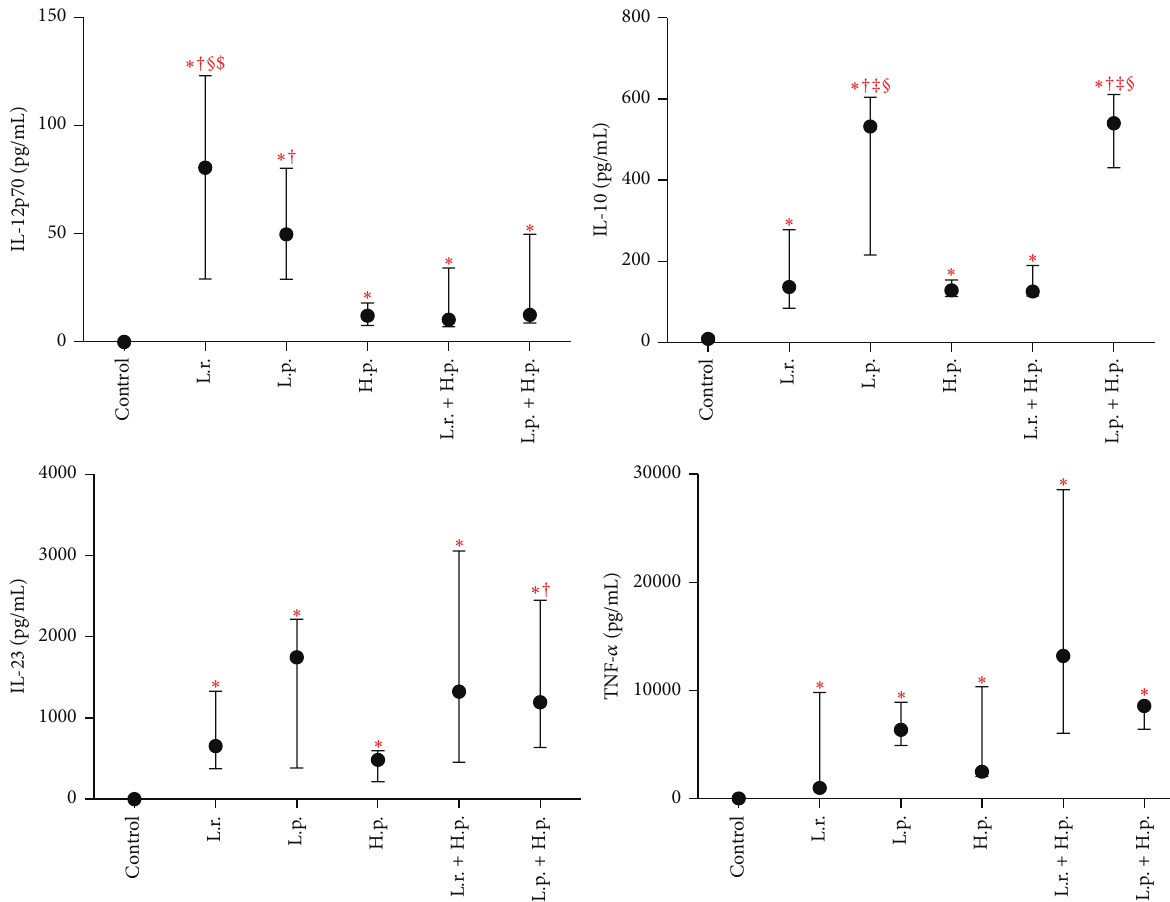
Figure 2: Effect of the examined bacteria and their mixtures on the production of cytokines by DCs population. Values expressed as medians from six independent experiments and interquartile ranges [Q1–Q3]; control: unstipulated DCs; L.r.: L. rhamnosus 900; L.p.: L. paracasei 915; H.p.: H. pylori ; statistically significant differences are given as follows: ∗ : stimulators versus control (unstimulated DCs), † : stimulators